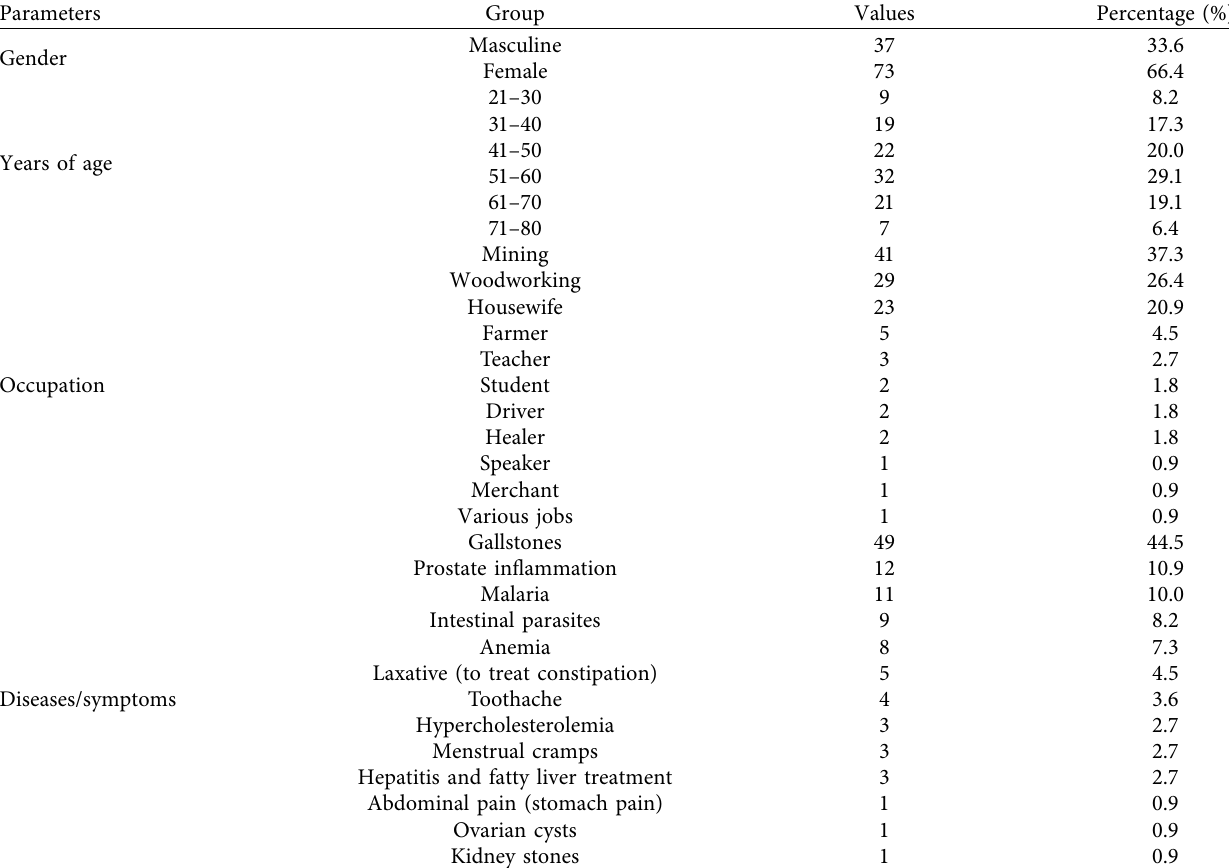
Table 1: Summary of ethnomedicinal information and demographic characteristics of the people surveyed ( n � 110).